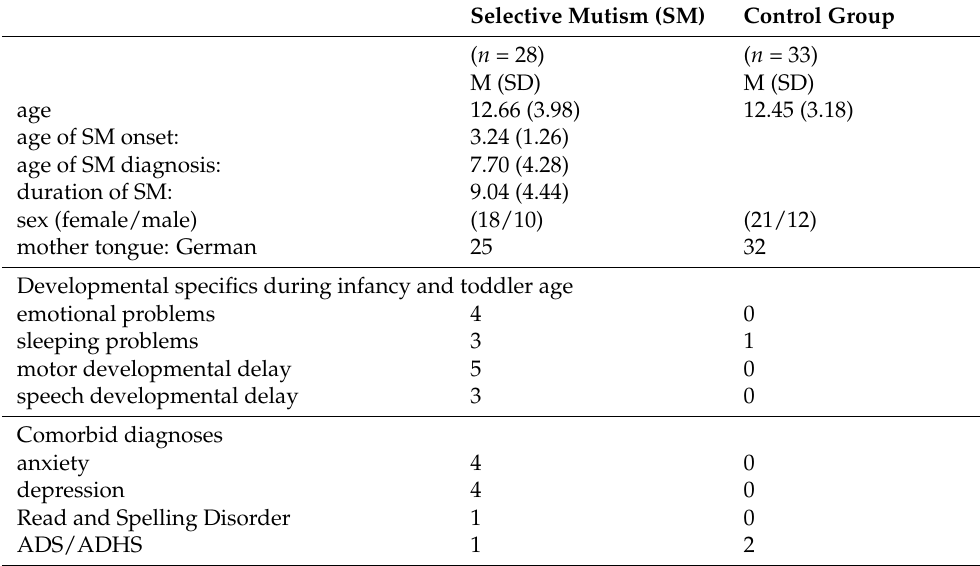
Table 1. Demographics [31,32].